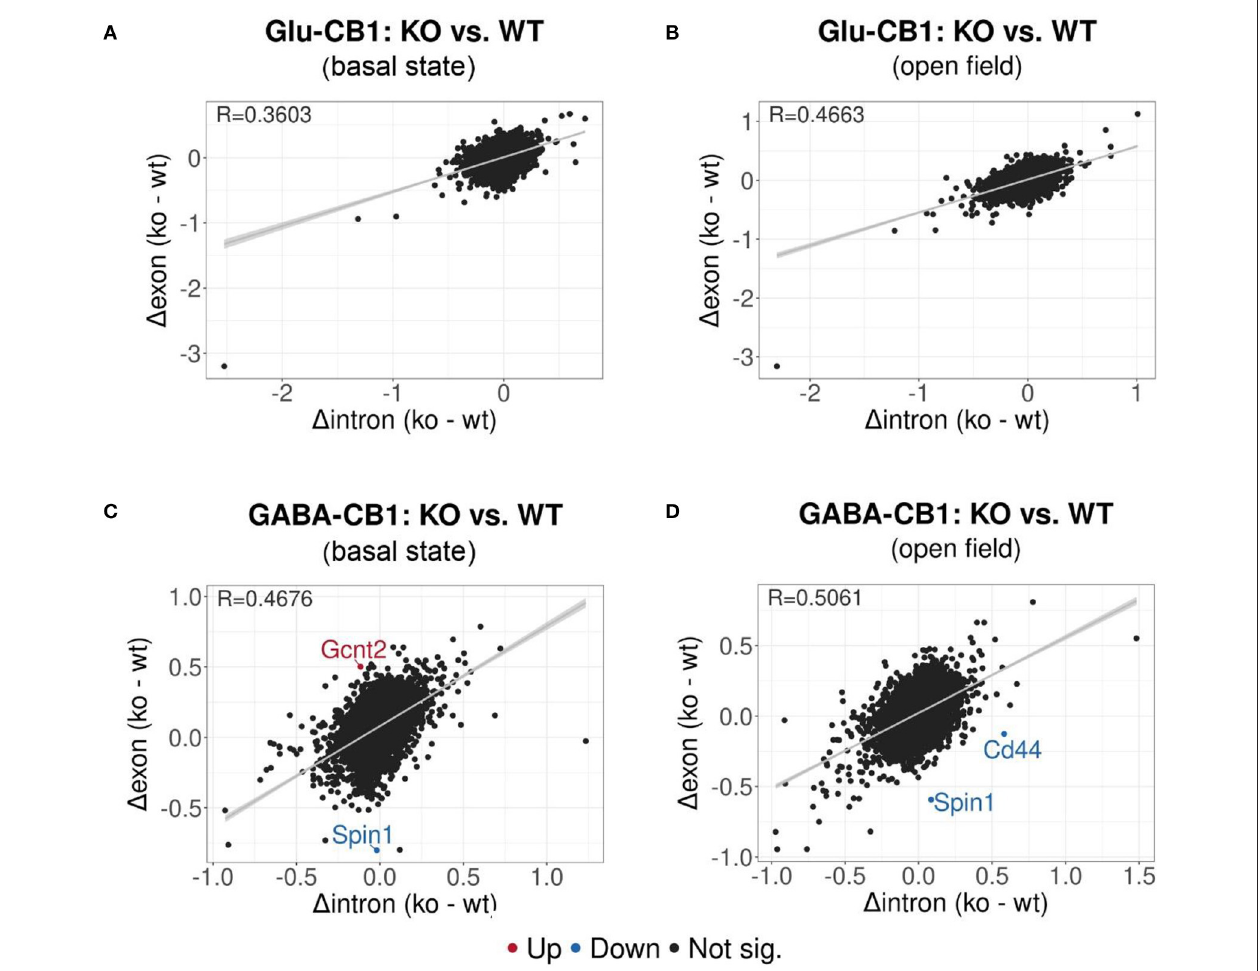
FIGURE 5 | EISA analysis of the Glu-CB1 and GABA-CB1 comparisons in the basal state and after open field exposure. Dot plots representing the change in exonic and intronic counts for each gene (dots). The value R at the top left corner of each graph indicates the slope of the regression curve, as well as the tendency on whether the overall changes in gene expression are due to transcriptional (R = 1) or posttranscriptional (R = 0) changes. (A) EISA data resulting from comparing Glu-CB1-KO vs. CB1-WT mice in the basal state. (B) EISA data resulting from comparing Glu-CB1-KO vs. CB1-WT mice after open field exposure. (C) EISA data resulting from comparing GABA-CB1-KO vs. CB1-WT mice in the basal state. (D) EISA data resulting from comparing GABA-CB1-KO and CB1-WT mice after open field exposure. Significant post-transcriptionally regulated genes comparing conditional CB1-KO and CB1-WT mice are labeled and colored in red for upregulation and blue for